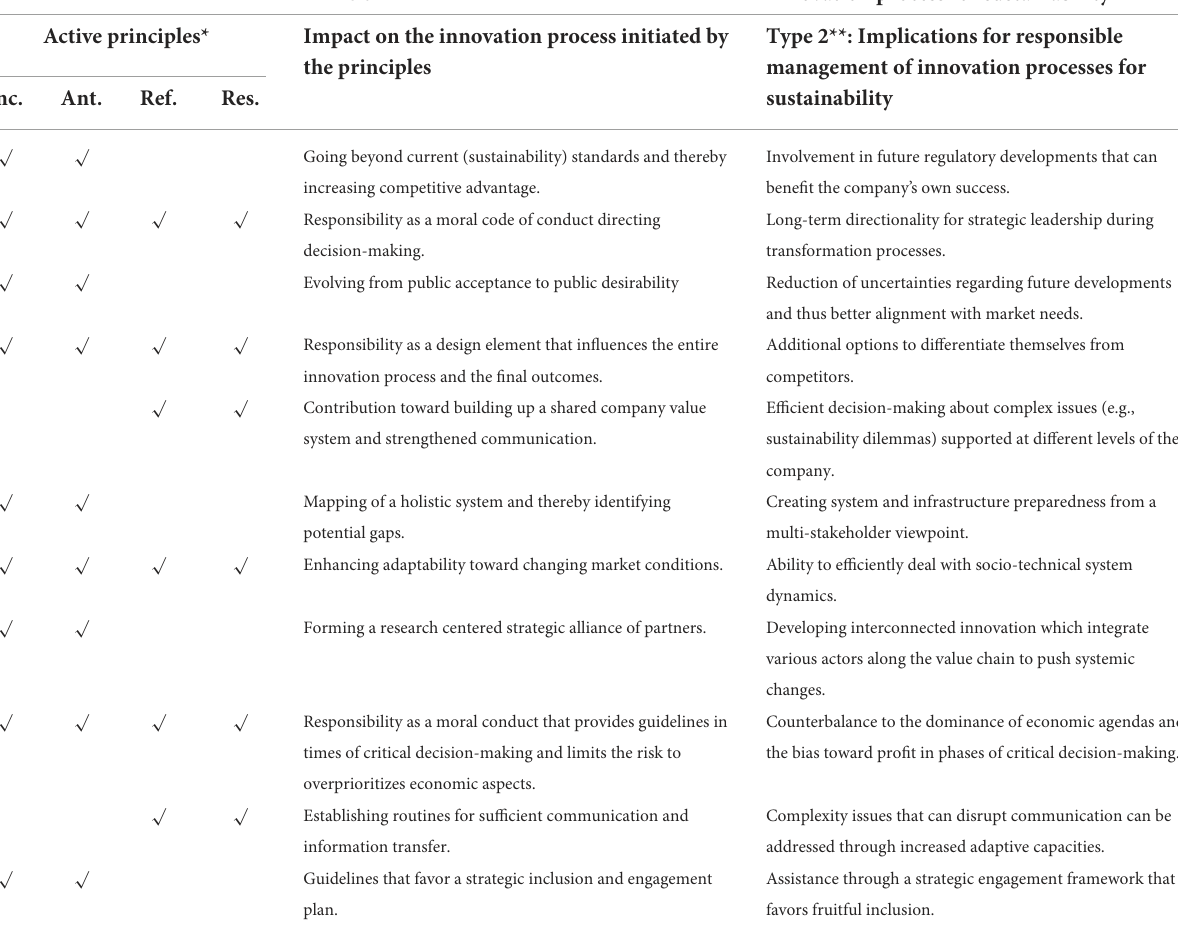
TABLE 5 Contribution of RRI principles on innovation processes for